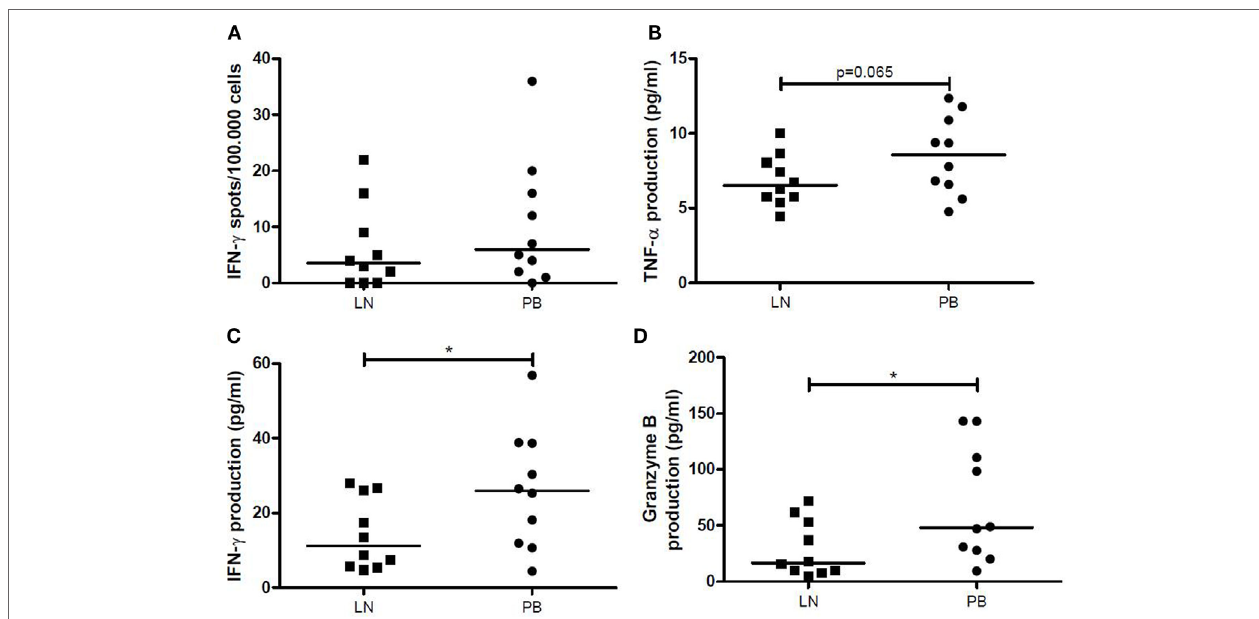
FigUre 5 | IFN- γ , TNF- α , and granzyme B production after allogeneic stimulation. (a) The number of IFN- γ spots per 100,000 cells by LNMCs and PBMCs after allogeneic stimulation for 1 day is shown. The production of (B) TNF- α , (c) IFN- γ , and (D) granzyme B (pg/mL) by LNMCs and PBMCs after allogeneic stimulation for 6 days is shown. Data are shown as individual points and medians. Significant differences were calculated and shown (* p < 0.05, ** p ≤ 0.01, *** p ≤ 0.001). IFN- γ , interferon-gamma; LNMCs, lymph node mononuclear cells; PBMCs, peripheral blood mononuclear cells; TNF- α , tumor necrosis